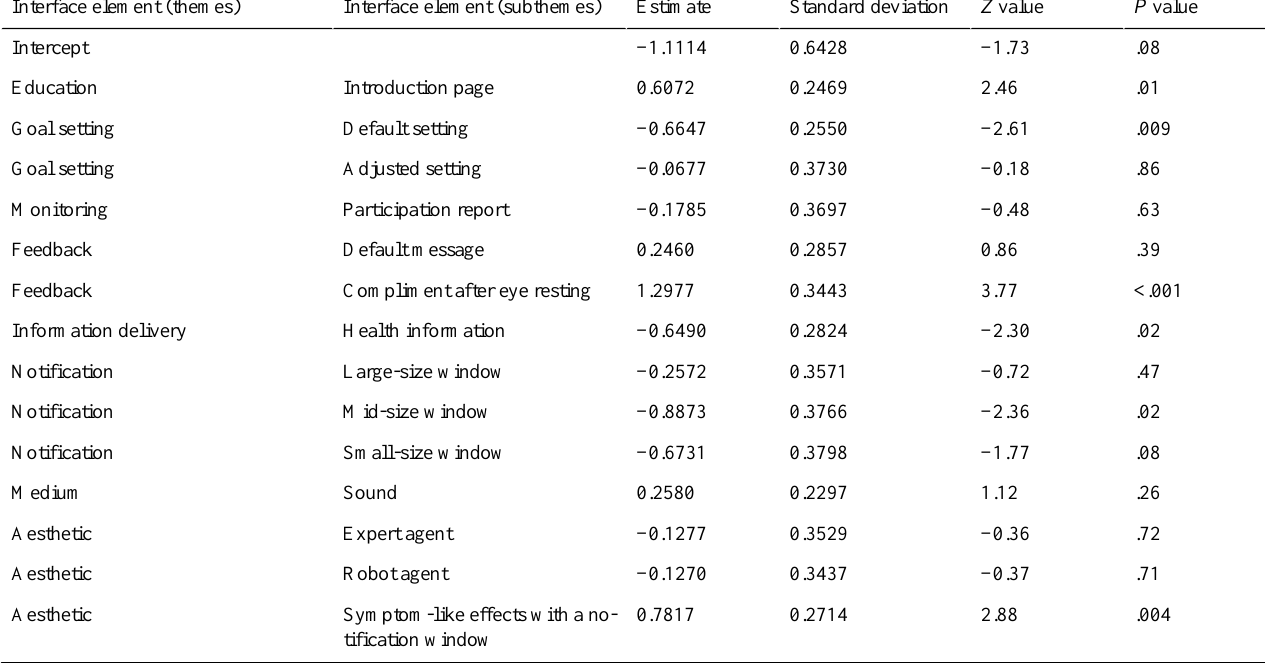
Table 4. Results of multiple regression